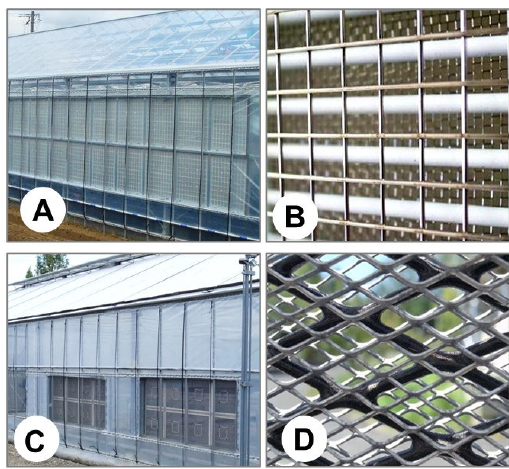
Figure 12. ( A , B ). Practical application of an SD screen (Sonoda Seisakusho Co. Ltd Osaka, Japan.)